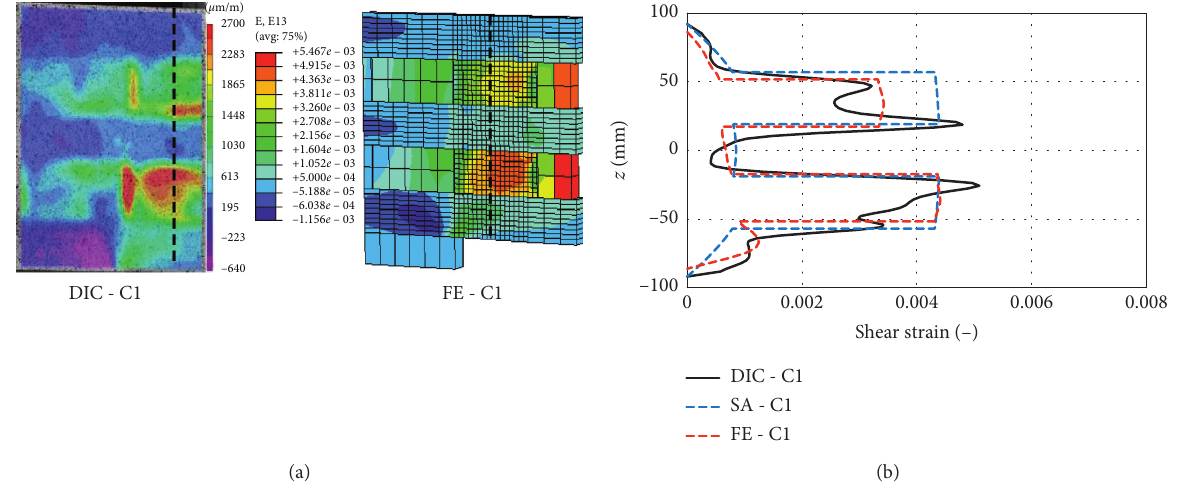
Figure 8: Colour contour plots and shear strain distribution from shear tests for C1.